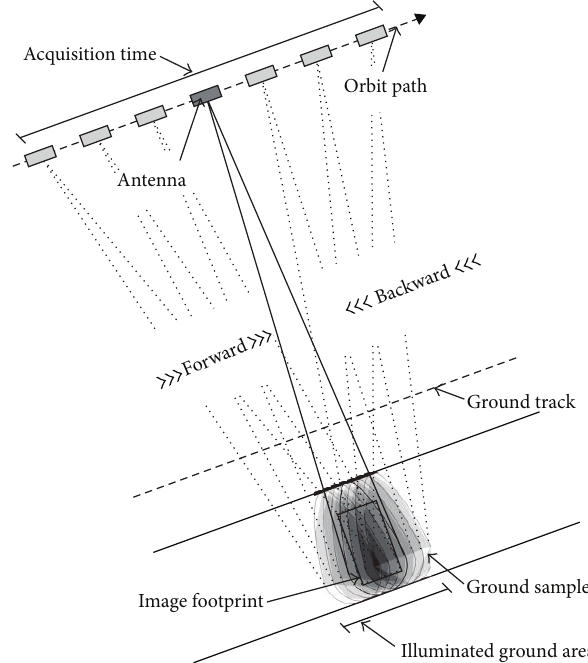
Figure 5: Image acquisition geometry for spotlight mode. The beam is steered backwards when the satellite passes the area of interest [4].